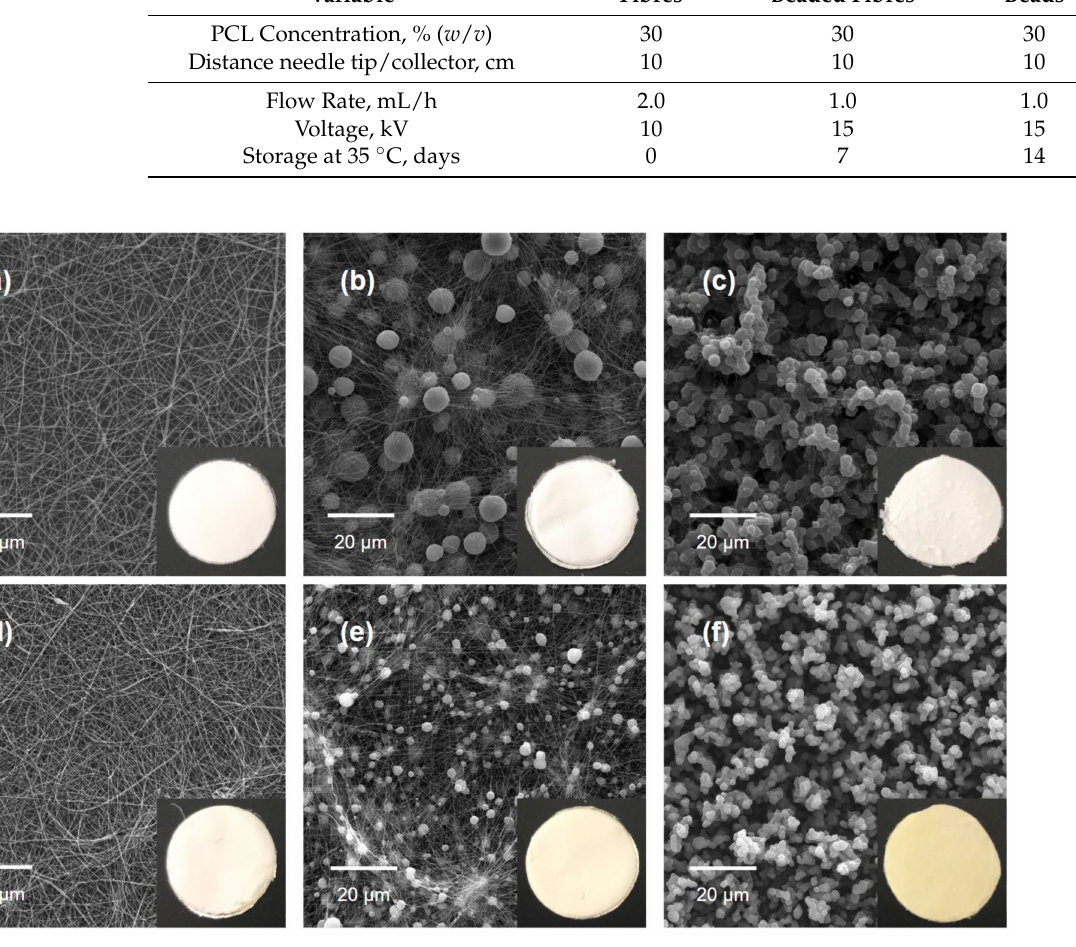
Figure 3. Scanning electron microscopy images and macrographs (disks of 1.5 cm diameter) of electrospun mats from solution storage for different periods: ( a , d ) 0 day (PCL fibres, PCL + Prop fibres); ( b , e ) 7 days (PCL beaded fibres, PCL + Prop beaded fibres); ( c , f ) 14 days (PCL beads, PCL + Prop